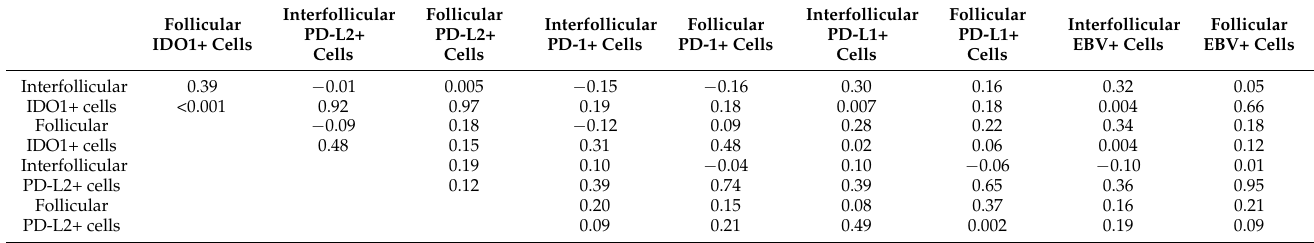
Table 2. Correlation of interfollicular and follicular cells in cases and controls. Spearman rho correlation coefficient and p